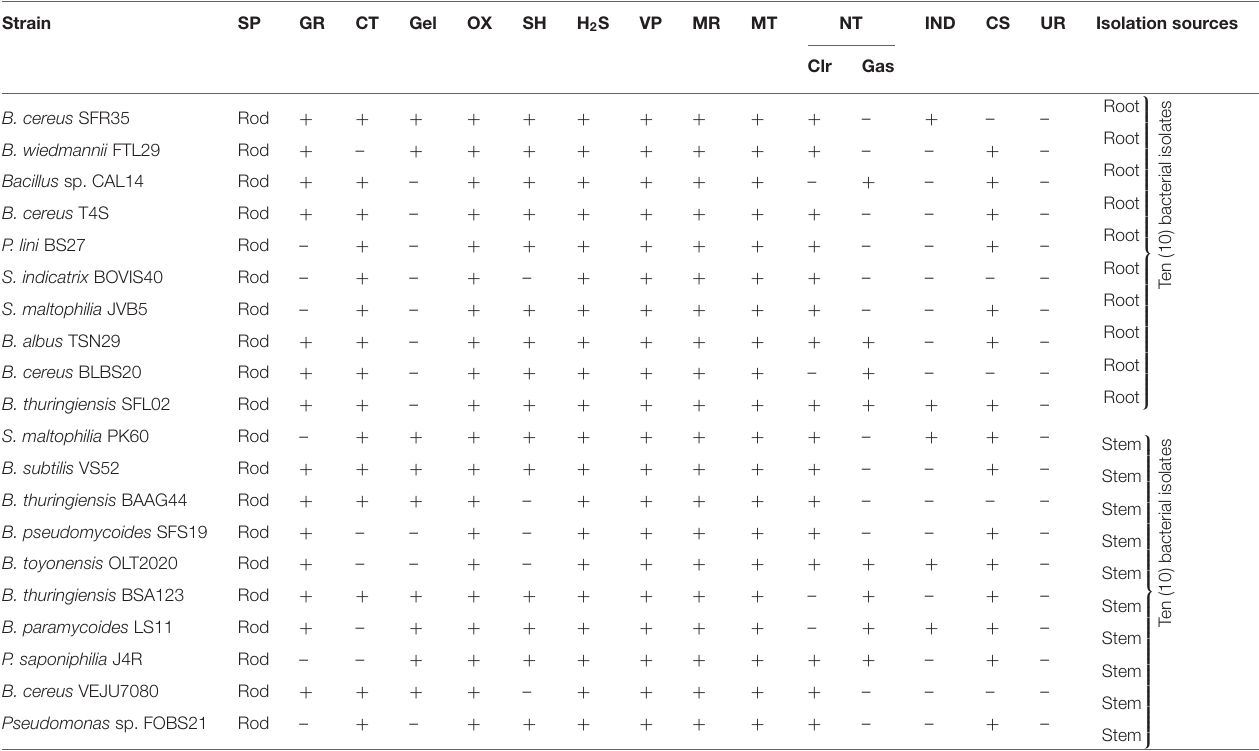
TABLE 1A | Biochemical characterization of endophytic bacteria from sunflowers.